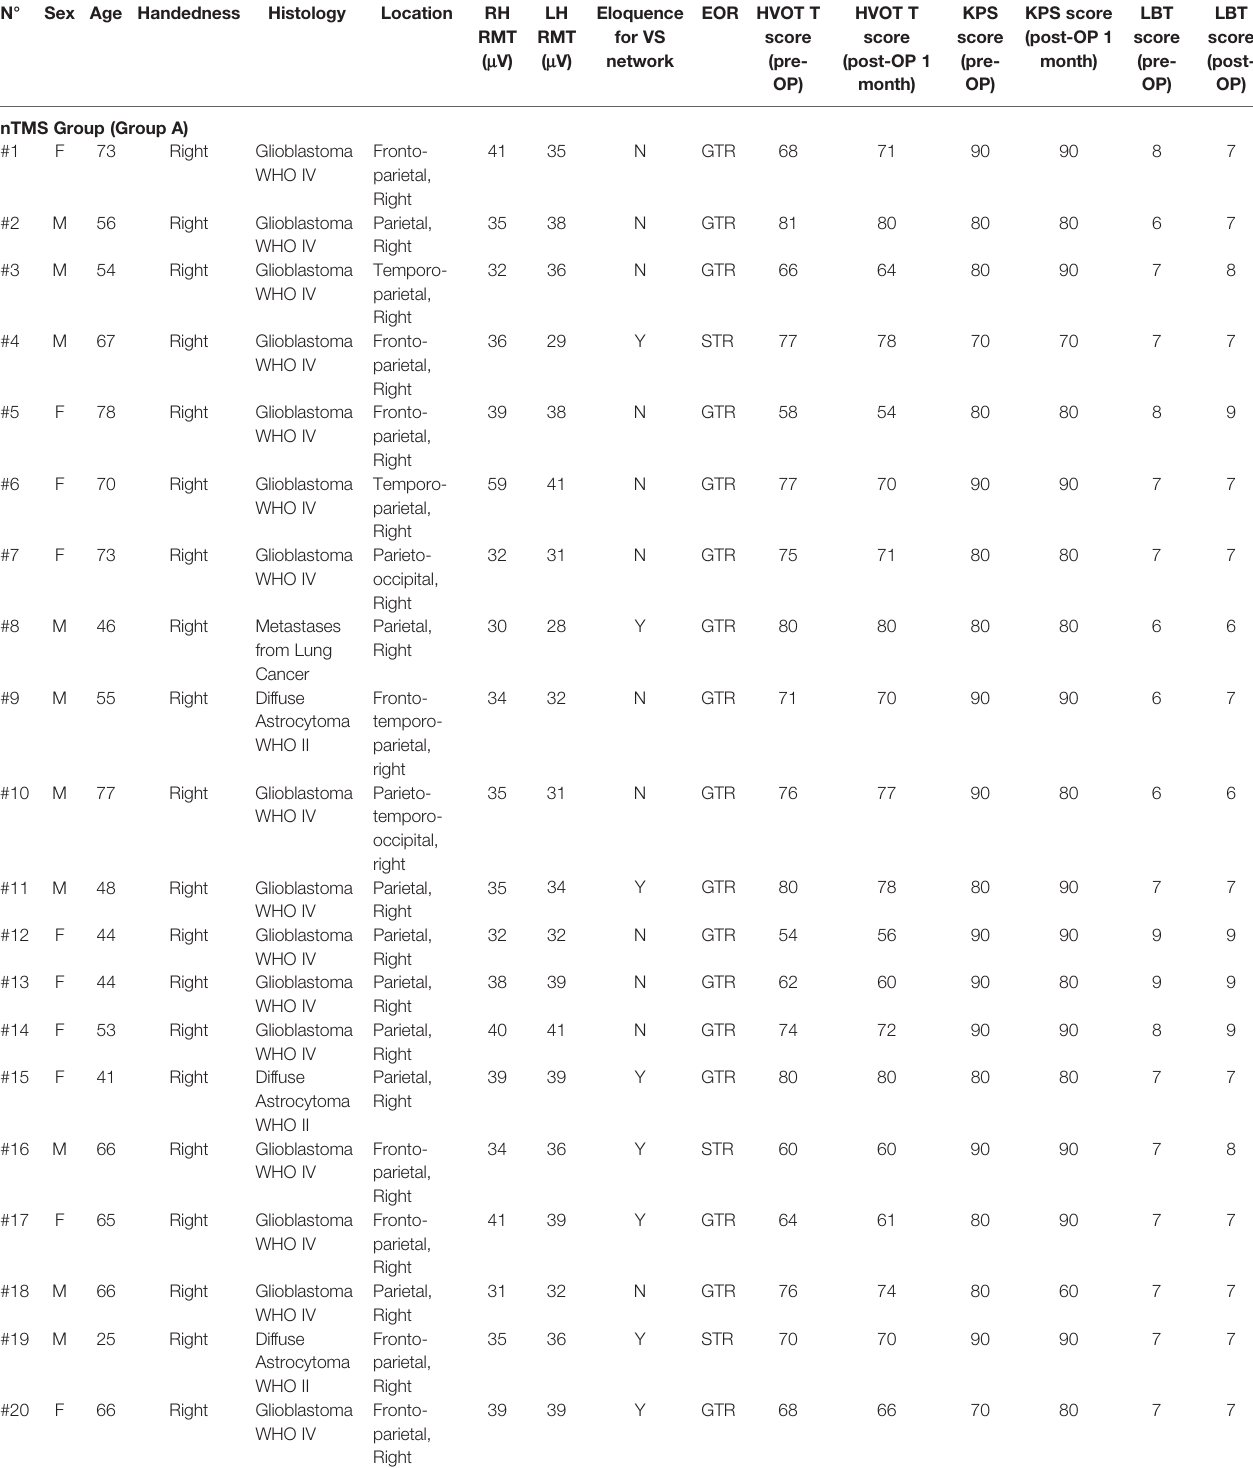
TABLE 1 | Salient demographic and clinical characteristics of patients in Group A and B, as well as nTMS mapping features of patients in Group A. N° Sex Age